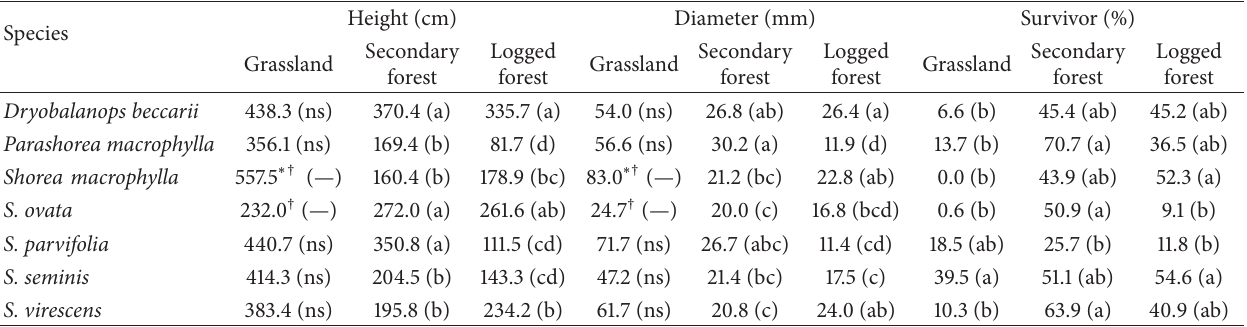
Table 5: Seedlings height (cm), diameter (mm), and percentage of survivors (%) in relation to all planted individuals at 81 months of seven dipterocarp forest